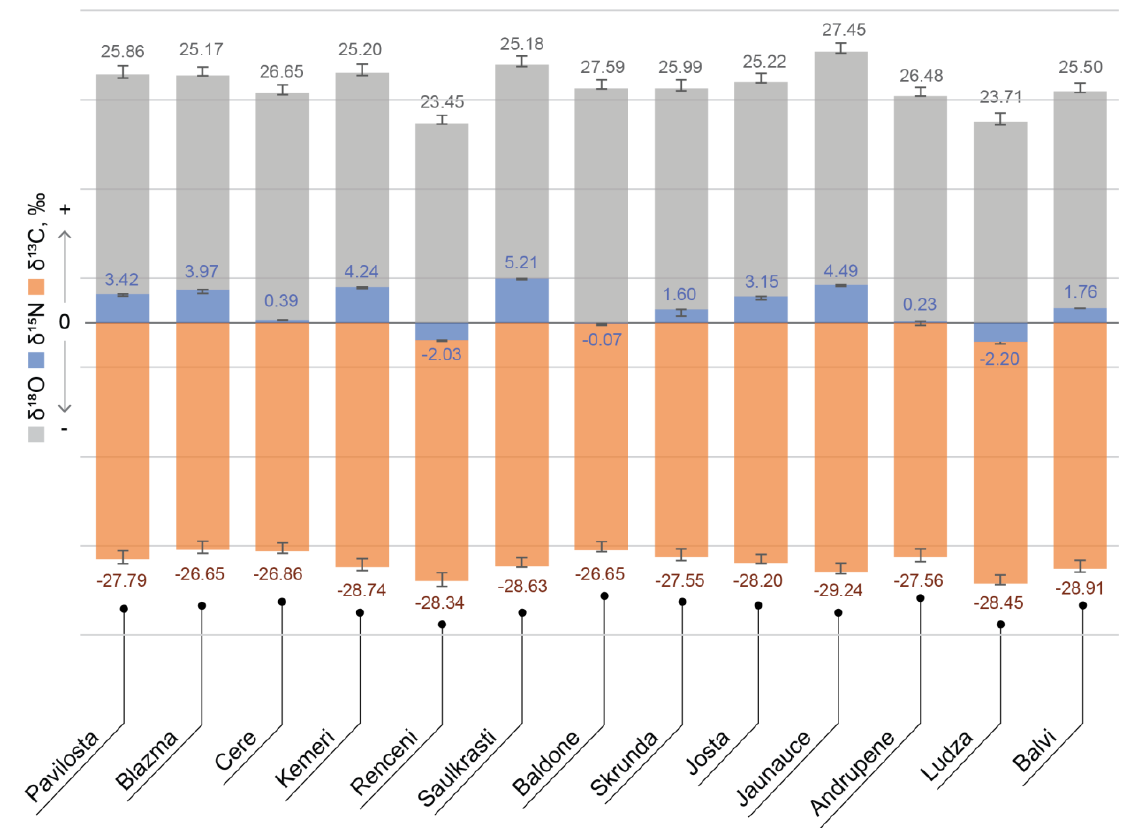
Figure 4. Light stable element isotope (δ 13 C, δ 15 N, δ 18 O) ratio values in bilberries from different locations in Latvia. Error bars represent standard error between the replicates ( n = 5). Foods 2021 , 10 , x FOR PEER REVIEW